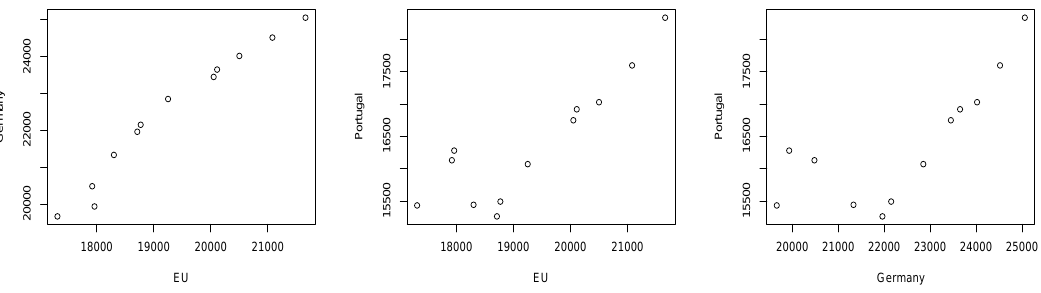
Figure 1: Annual main GDP aggregates per capita in the European Union versus Germany (left), European Union versus Portugal (center) and Germany versus Portugal